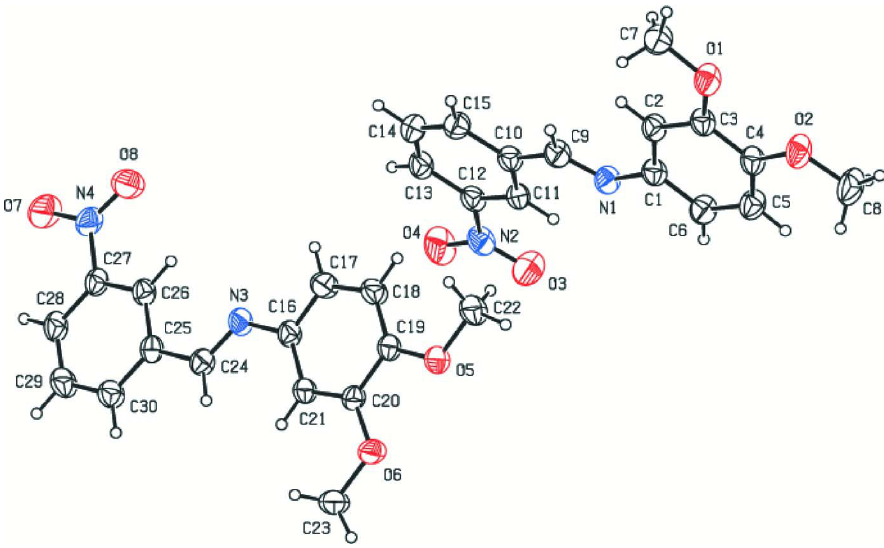
Figure 1 A view of the two independent molecules in the asymmetric unit of the title compound, with the atom-numbering scheme and 30% probability displacement